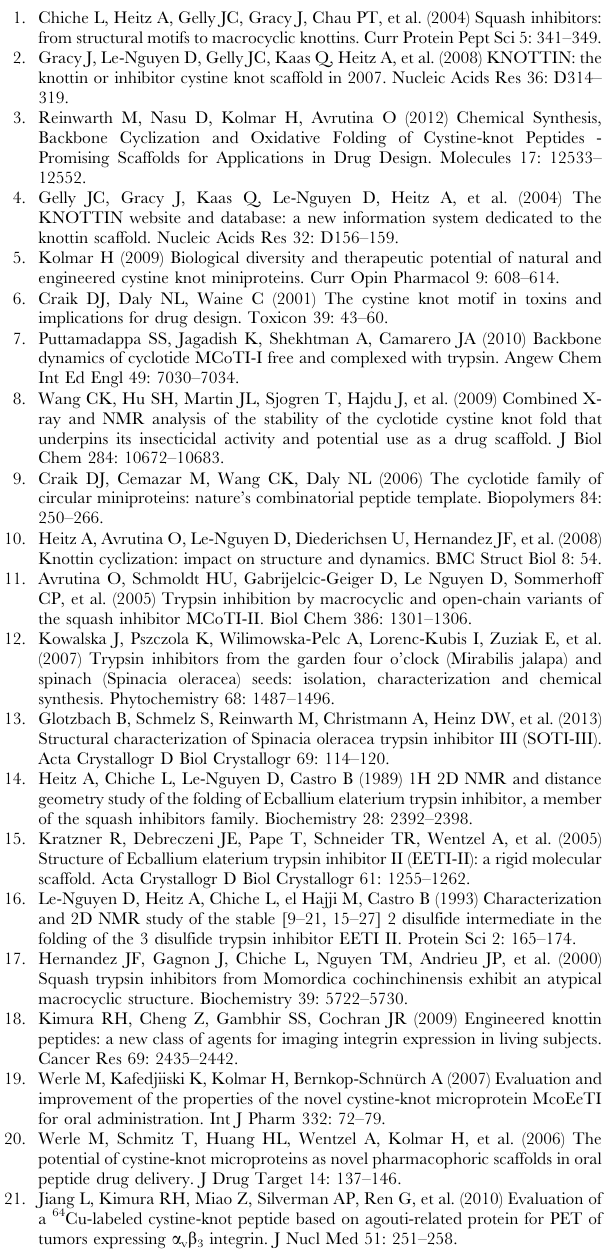
Figure S9 CD spectroscopy of the reduced (unfolded) and oxidized (folded) variants of SOTI wt and SOTI Var. 1. Smoothed with the ‘smooth’ function of Sigma Plot 11. Figure S10 CD spectroscopy of the reduced (unfolded) and oxidized (folded) variants of MCoTI wt and MCoTI Var. 4. Smoothed with the ‘smooth’ function of Sigma Plot 11. Table S1 Apparent inhibition constants towards ma- triptase-1 of the isolated cyclic MCoTI variants. Table S2 Characterization of synthetic